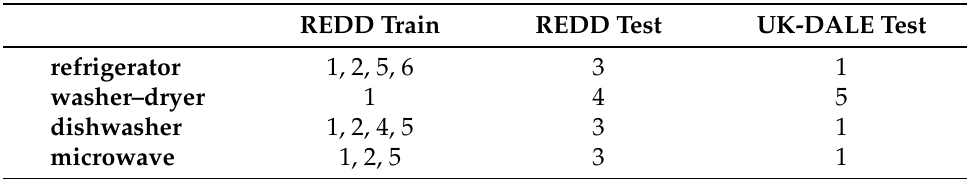
Table 8. House to the originating domain per appliance